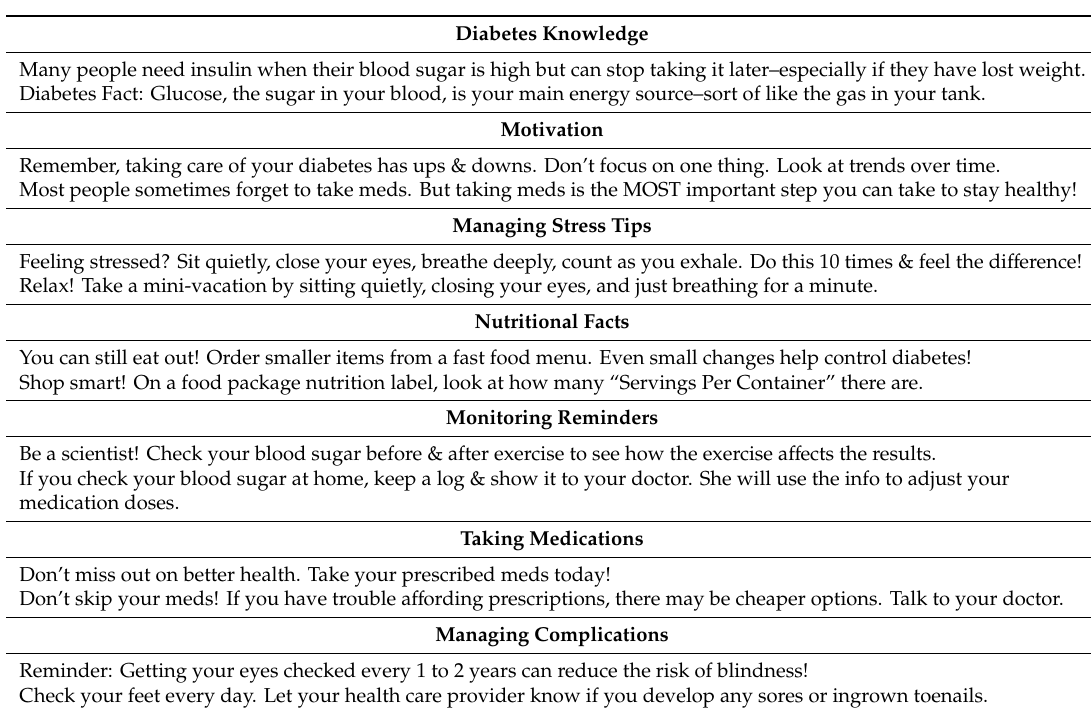
Table 1. Examples of the non-tailored automated one-way SMS content. A full description can be accessed in the Supplementary Materials (File